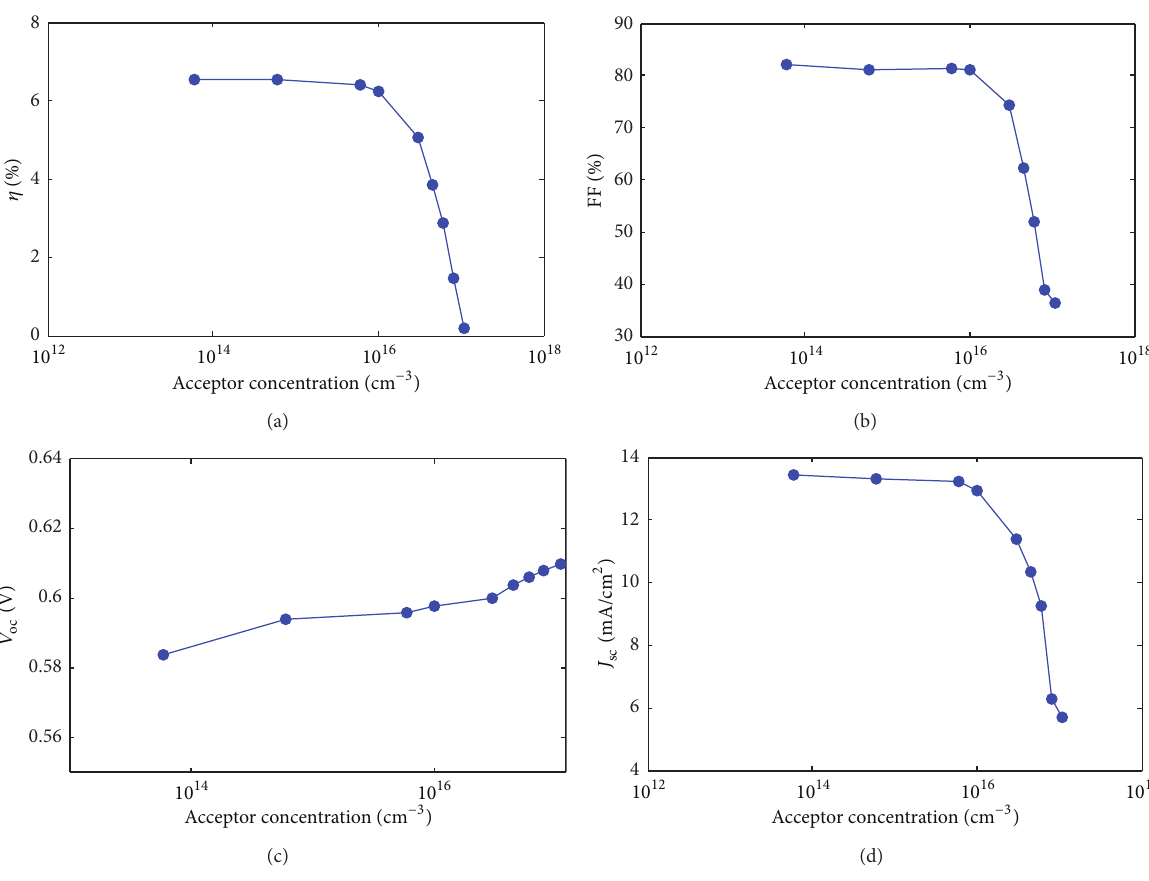
Figure 4: The effect of acceptor concentration, ( p ) in the SWCNT layer, on the performance parameters with an optimum value of about 10 16 cm −3